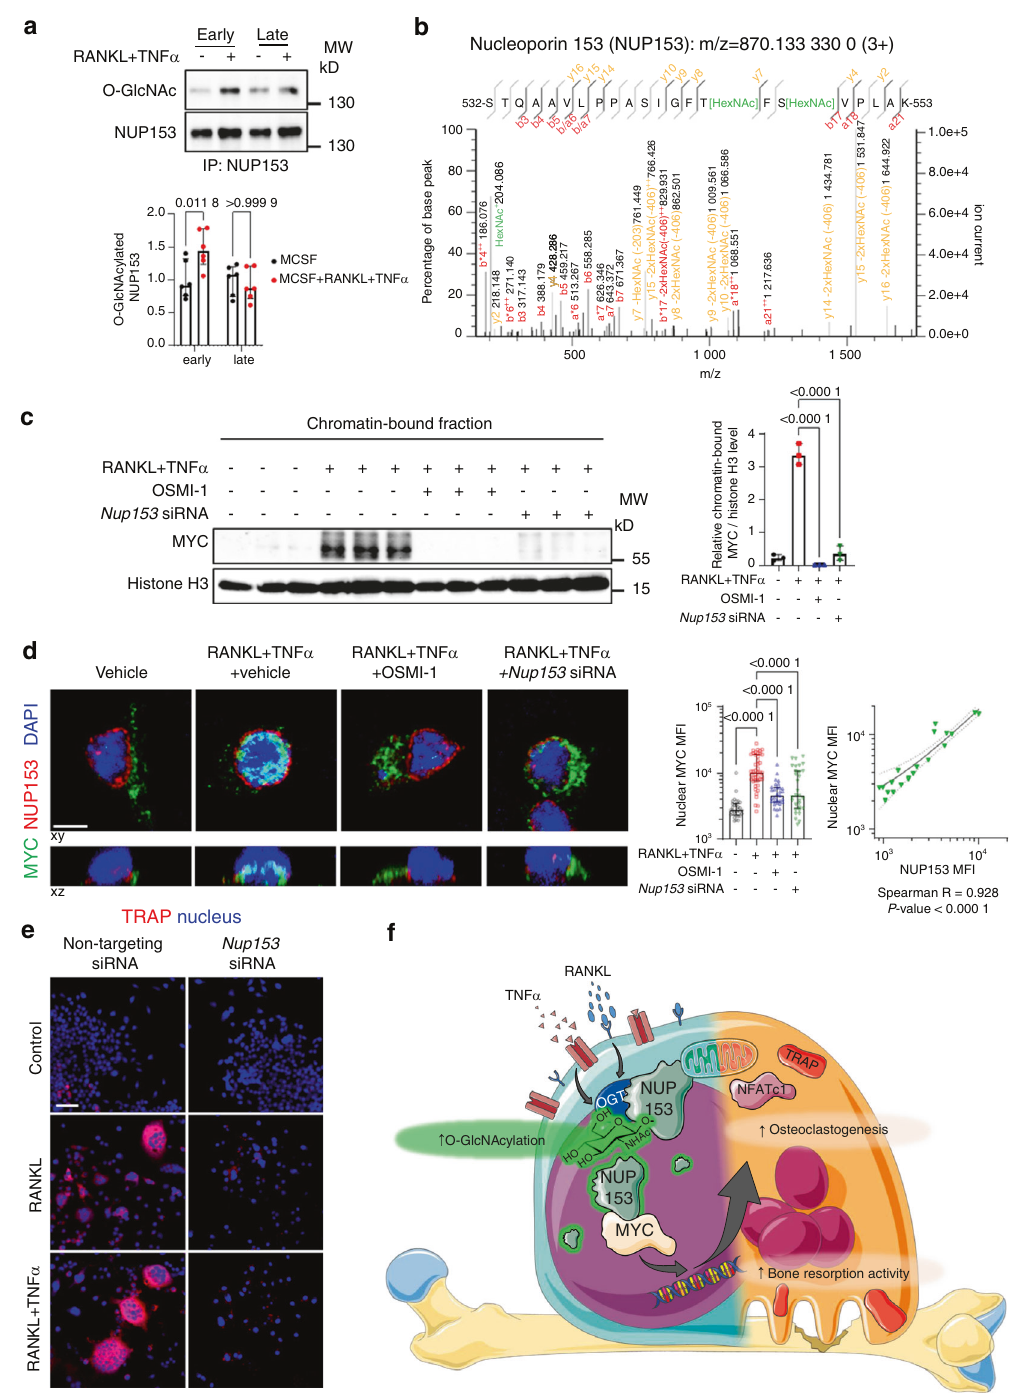
Fig. 7 O-GlcNAcylation target NUP153 is essential for MYC nuclear accumulation and osteoclastogenesis. a Levels of O-GlcNAcylation on NUP153 in early and late stages of osteoclastogenesis by immunoprecipitation ( n = 6 per group). b MS2 spectrum of O-GlcNAcylated peptide in NUP153 from RANKL and TNF α costimulated RAW264.7 cells. c Western blot analysis for chromatin-bound MYC in the cells with Nup153 knockdown or OSMI-1 ( n = 3 replicates). d Representative immuno fl uorescence images of confocal microscopy and quanti fi cation of the median MYC intensity within the nuclear volume in the cells treated with OSMI-1 and Nup153 siRNA ( n ≥ 30 cells per group). Spearman correlation analysis on the intensities of MYC and NUP153 in cells treated with Nup153 siRNA ( n = 20 cells). Unless speci fi ed, cells were treated with vehicle and non-targeting siRNA. e Representative images for TRAP staining on cells transfected with Nup153 siRNA. f Conceptual scheme of the functional role of O-GlcNAcylation modulation of NUP153 during osteoclastogenesis. The illustration was created by using images from Servier Medical Art (http://smart.servier.com/) and Scheng23 (https://commons.wikimedia.org/wiki/File:O-GlcNAc_cycling-1.png), licensed under CC BY 3.0 (https://creativecommons.org/licenses/by/3.0/) and CC BY-SA 4.0 licenses (https://creativecommons.org/licenses/by-sa/4.0/), respectively. Bar graphs are shown as median ± IQR. Horizontal scale bars represent 5 µm ( d ) or 50 µm ( e ) in IF images. Statistical signi fi cance was determined by two-way ( a ) or one-way ANOVA ( c , d ). P -values and Spearman ’ s ρ are presented in the graphs. Linear regression and its 95% con fi dence interval (dashed line) are presented in the correlation plots ( d ). MFI, median fl uorescence